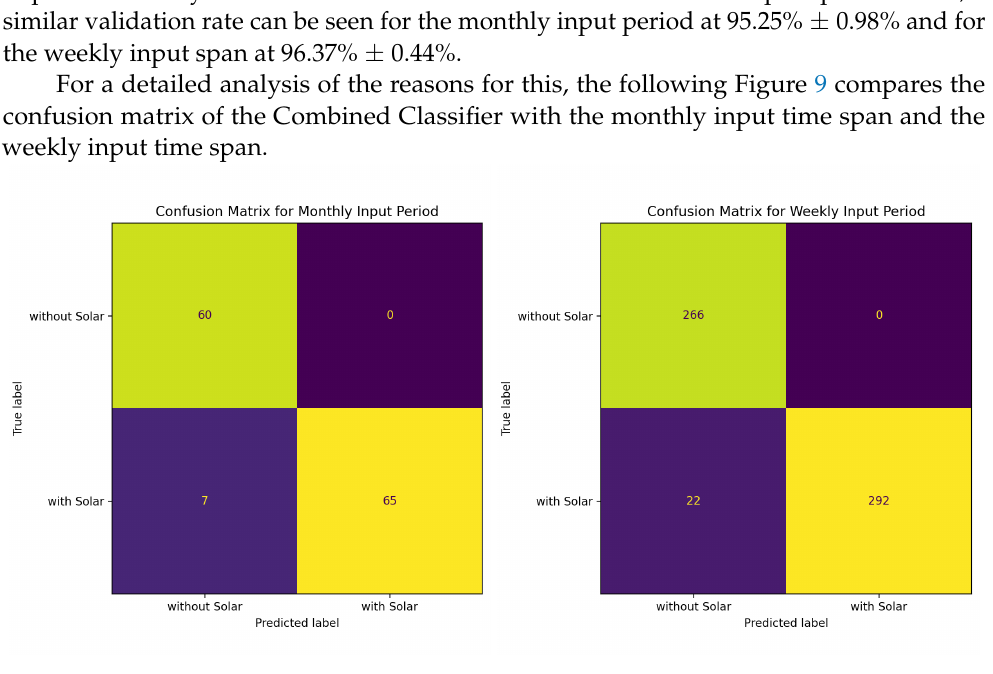
Figure 9. Comparison of the Combined Classifier confusion matrix with the monthly input time period and the weekly input time period for detecting the power generation of a photovoltaic